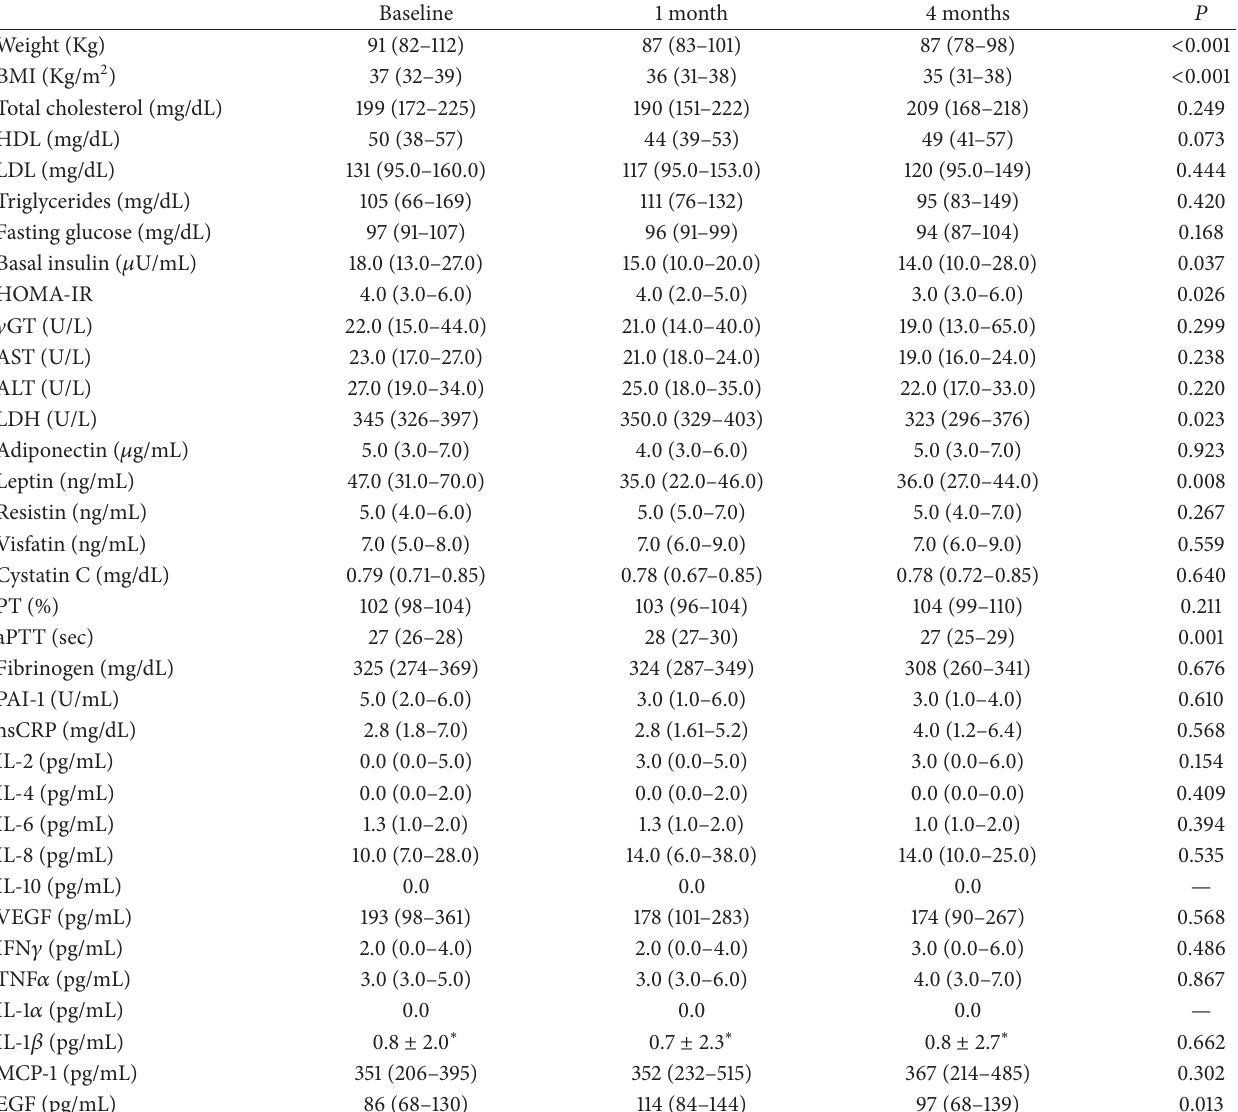
Table 2: Comparison of demographic, anthropometric, clinical, and biochemical features of obese patients at baseline and during follow-up. Baseline